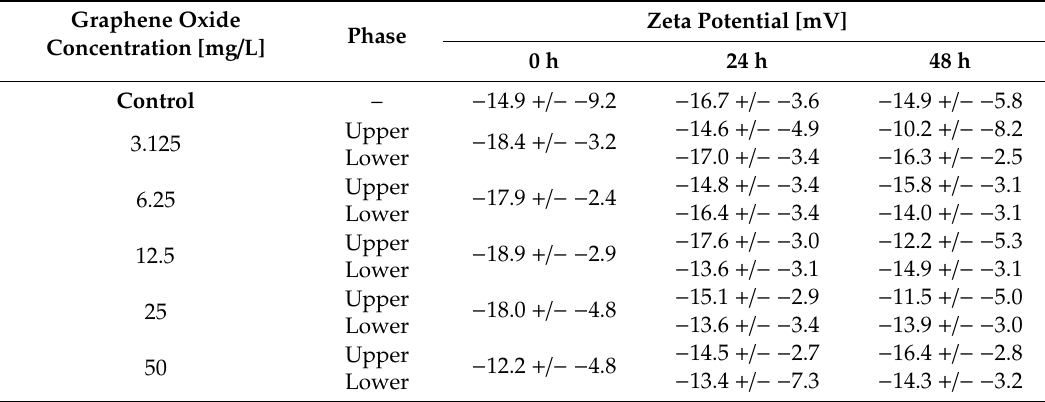
Table 1. Zeta potential values measured in the assembled test systems after 24 and 48 h of exposure reported from n = 3 determinations per